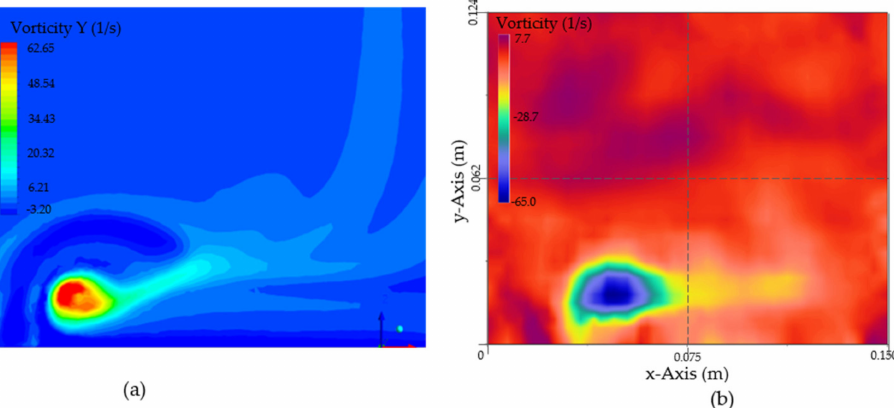
Figure 8. Comparison of vorticity: ( a ) steady-state CFD results (SST turbulence model); ( b ) time- averaged PIV results.